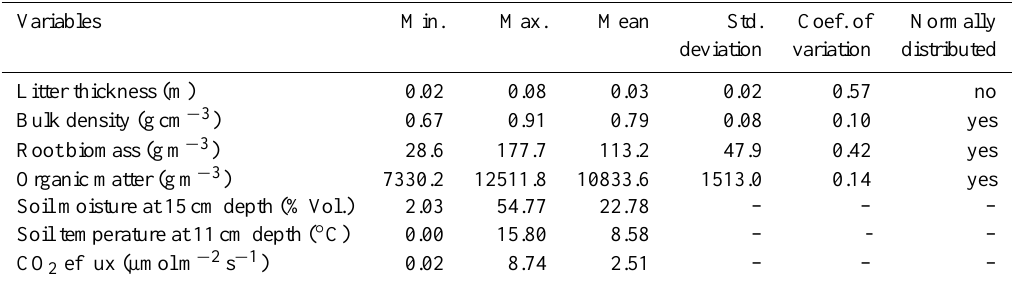
Table 1. Descriptive statistics (n = 984 observations) for 10 sites (M1, M8, WA1, WA6, WA7, WA10, WA11, WA15, WB3, WB4) from 2006 to 2012 along two transects (cf. Fig. 1 for the locations of measurement sites and for more details). The symbol (–) means that the dynamic variables were not tested for